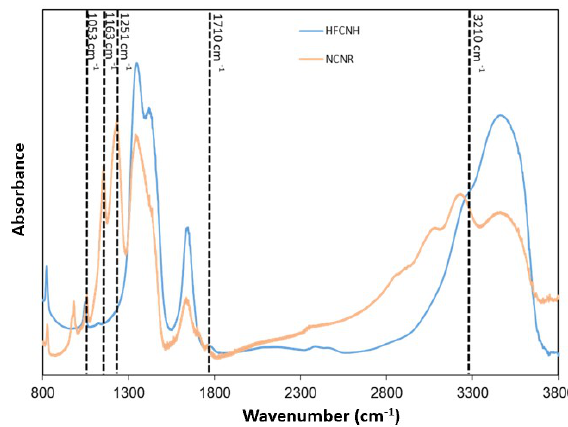
Figure 2. Fourier-transform infrared spectra of NCNR and HFCNH.